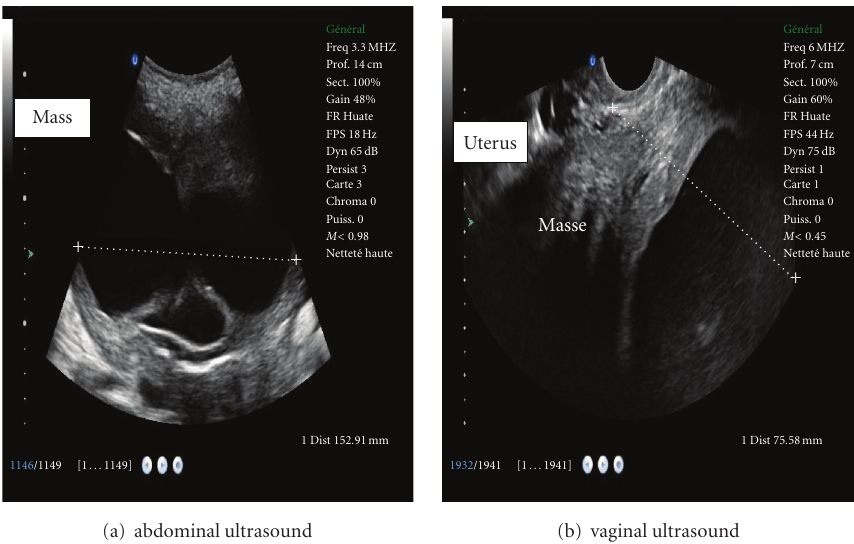
Figure 1: Showed a 15cm heterogeneous but well-circumscribed mass, consisting of cystic and solid parts, whose relationship with the uterus is not well defined; no vegetation was noted either inside or outside of the mass, and the ovaries were not